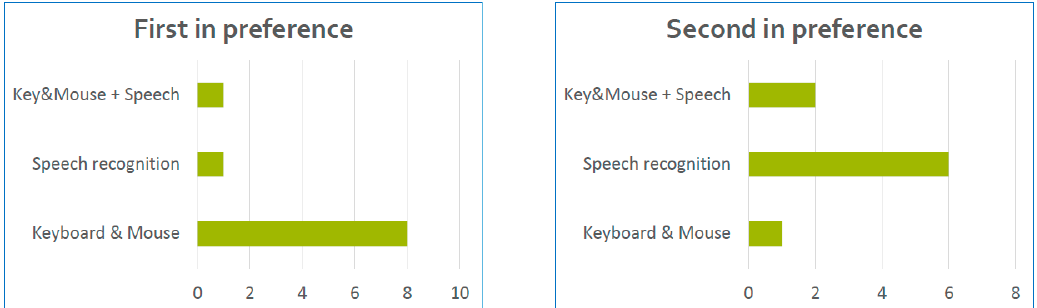
Figure 10. Number of characters produced in each of the interaction modes (means).